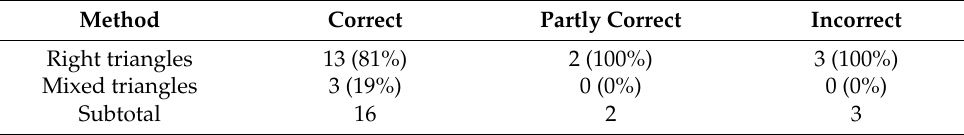
Table 4. Effect of different strategies on the performances in solving the first word problem. Method